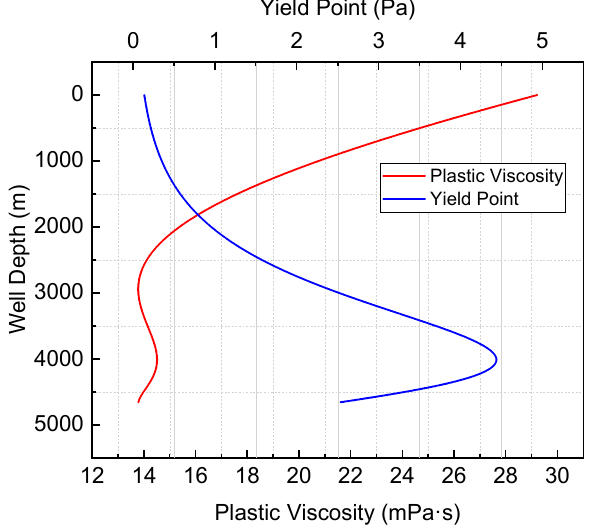
Figure 13. Variation curve of drilling fluid plastic viscosity and yield point with well depth.